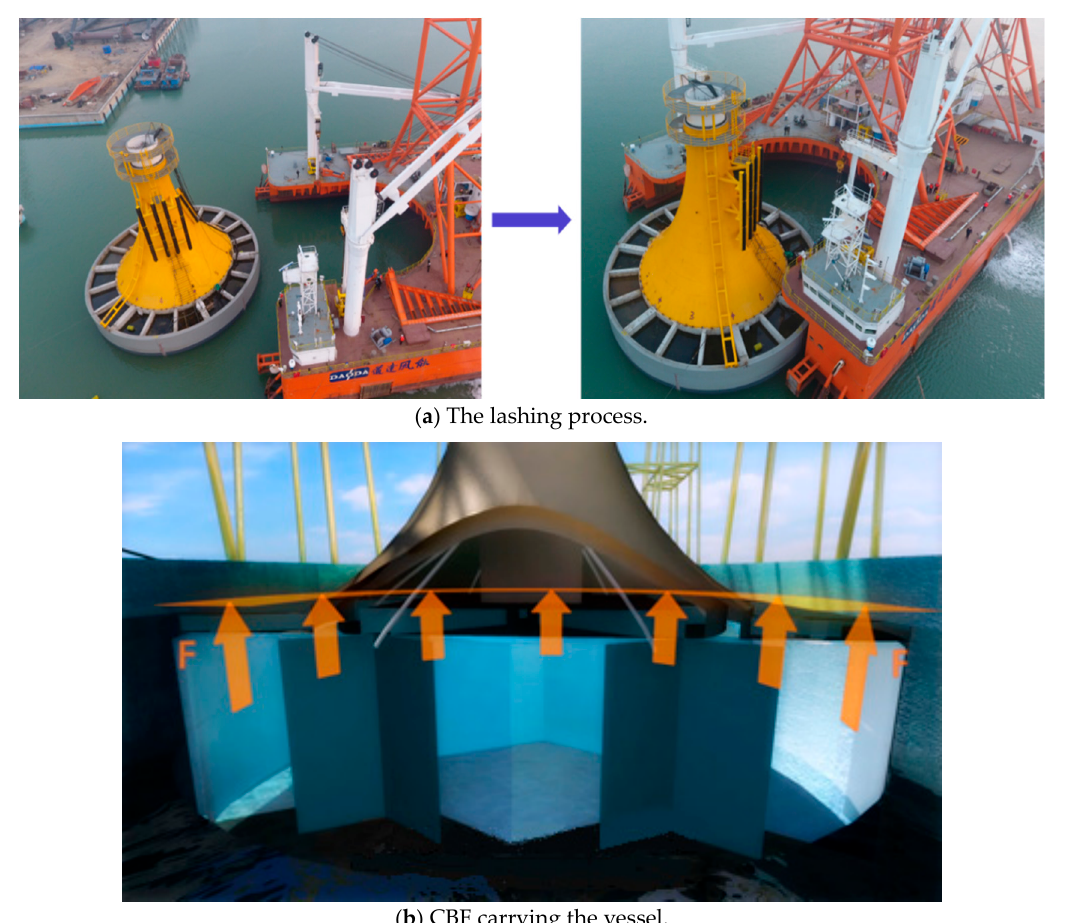
Figure 3. The connection method between the CBF and the vessel.